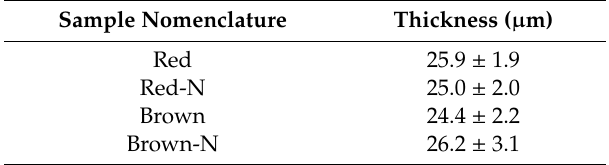
Table 3. Total thickness of the protective system (topcoat +